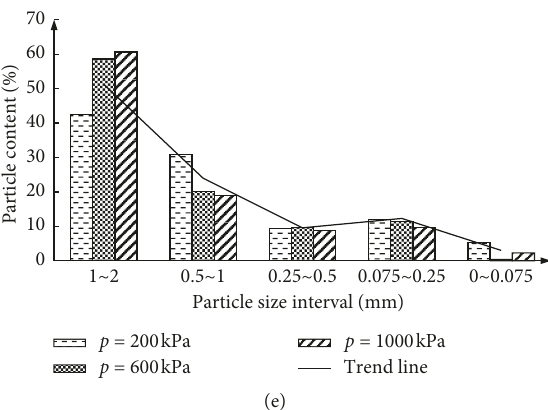
Figure 11: Sieve analysis histogram of particle breakage for different mean stresses. (a) b � 0, (b) b � 0.25, (c) b � 0.5, (d) b � 0.75, and (e) b � 1.